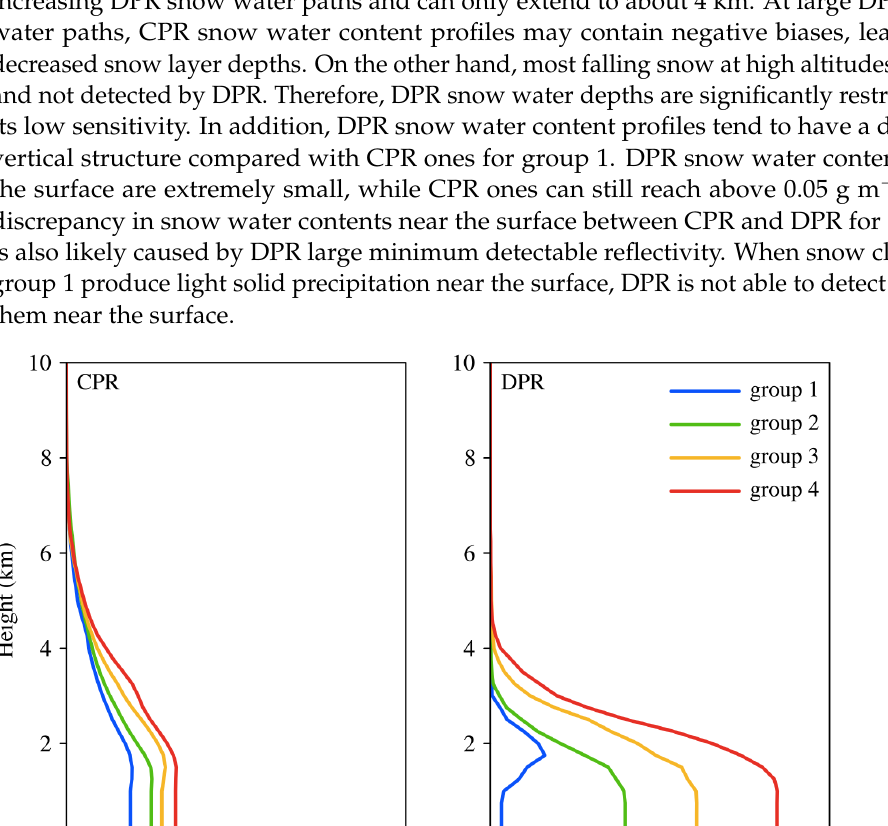
Figure 11. CPR and DPR mean snow water content profiles over oceans. Group 1 to 4 corresponds to DPR snow water path interval between 0 and 100 g m − 2 , 200 and 300 g m − 2 , 400 and 500 g m − 2 , 600 and 700 g m − 2 .